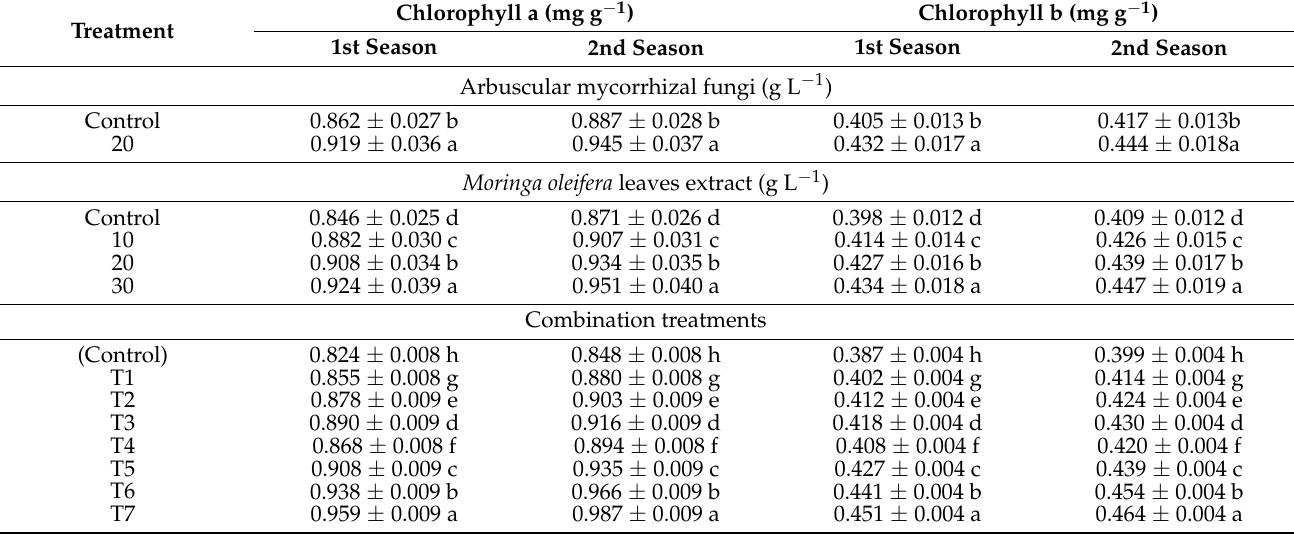
Data are mean value ± SE. Means in columns followed by the same letter are not statistically different at the 0.05 significance